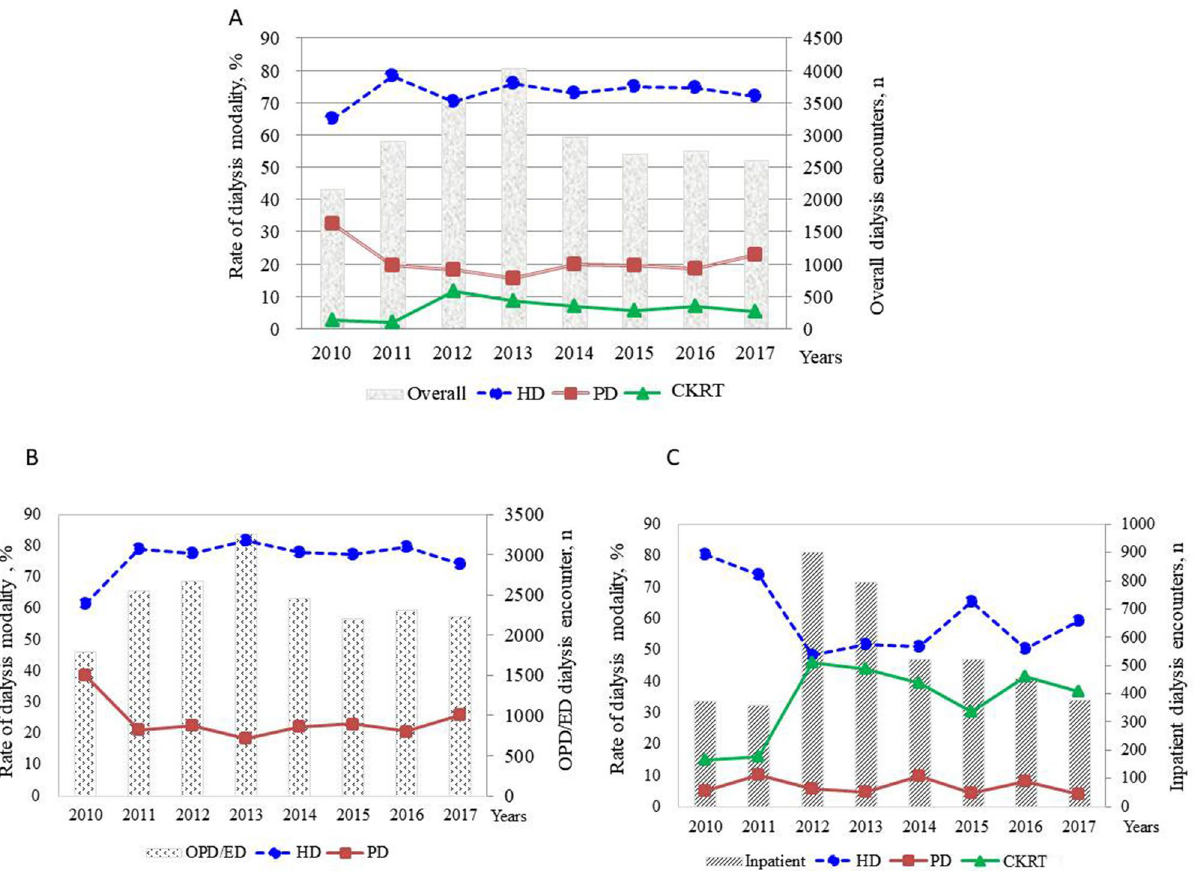
Figure 1. Annual rates of dialysis modality utilization among patients aged < 20 years treated between 2010 and 2017. All data are analyzed by the Cochran-Armitage Test for Trend (Statistical Analysis System version 9.4; SAS Institute, Cary, NC, USA). (A) Overall encounters for dialysis ( p = 0.0204). (B) Dialysis encounters in outpatient/ emergency department settings ( p < 0.0001). (C) Dialysis encounters in an inpatient setting ( p <